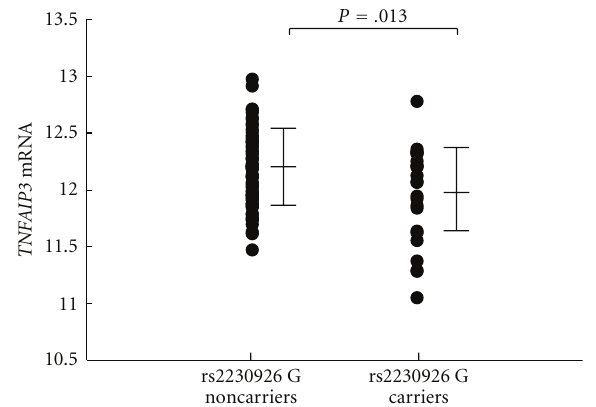
Figure 1: Association of TNFAIP3 rs2230926 with mRNA levels of TNFAIP3 . Because there was no subject with G/G genotype, TNFAIP3 mRNA levels were compared between rs2230926 G/T ( n = 24, mean ± SD: 12 . 0 ± 0 . 43) and T/T ( n = 65, mean ± SD: 12 . 2 ± 0 . 33) subjects by unpaired Student’s t -test. The mRNA levels were obtained from the mRNA expression profiling data in the B cell lines from the HapMap JPT and CHB subjects (GENEVAR